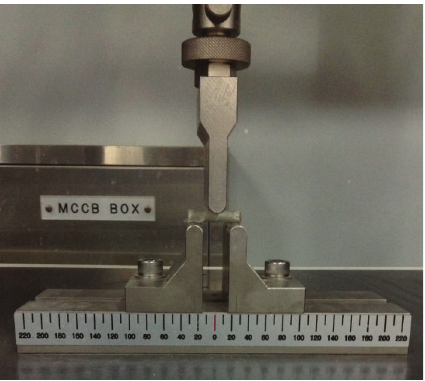
Figure 3: Shot beam test setup.